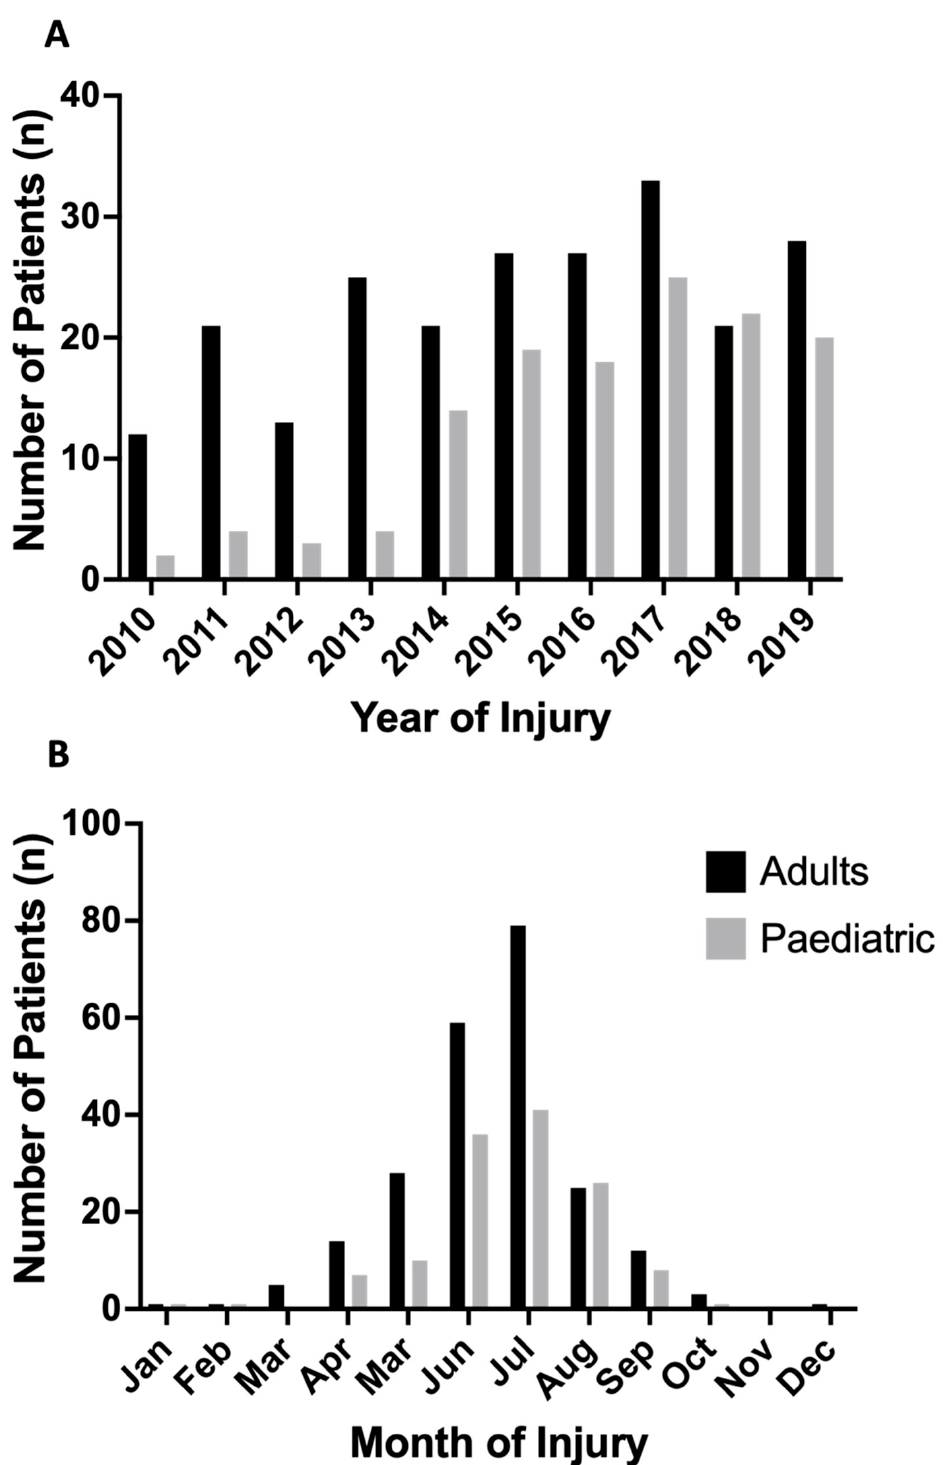
Figure 4. Adult and paediatric sunburn injuries stratified by date of injury. ( A ) sunburn injuries per year, demonstrating clear trend of increasing injury over study period. * note—limited record keeping in paediatric data prior to 2016 may exacerbate trend due to artificial low numbers in years prior to 2016. ( B ) sunburn injuries by month between 2010–2019, demonstrating predominance of injuries during northern hemisphere summer months (May–August) in adult and paediatric patients. Weekends accounted for over one third of sunburn injuries (adults—86/228, 37.7%, paediatric—43/131, 32.8%). Approximately 89.9% (205/228) and 86.3% (113/131) of